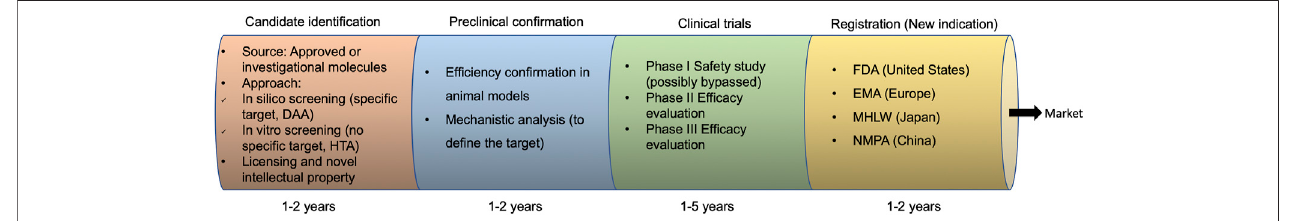
FIGURE 1 | Drug repurposing development process. DAA, direct-acting antivirals; HTA, host-targeting antivirals; FDA, Food and Drug Administration; EMA, the European Medicines Agency; MHLW, Ministry of Health, Labor, and Welfare; NMPA, National Medical Products